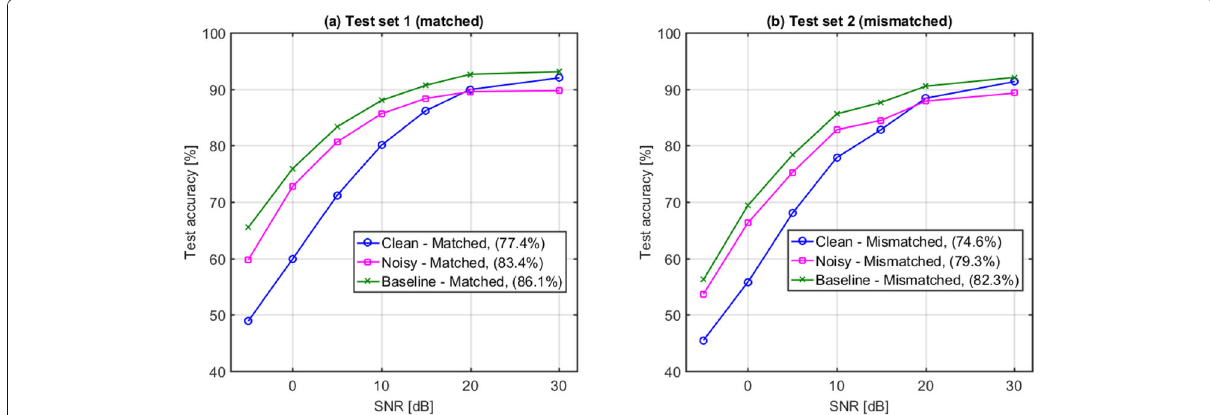
Fig. 5 Single-inference test accuracy of networks trained on clean and noisy speech. Networks were tested in both noise set 1 (matched) and noise set 2 (mismatched). The number in parentheses specifies the average accuracy in the range from 0 to 20 dB SNR. The performance of the baseline model trained on noisy data is shown for